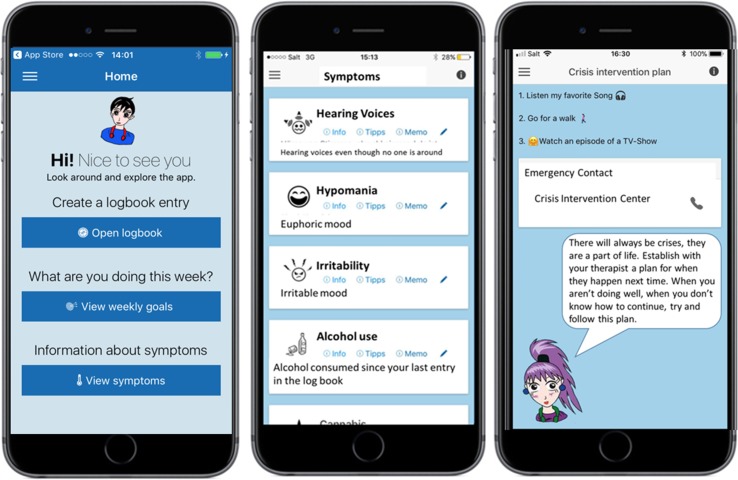
Example screenshots of the app Robin Z.